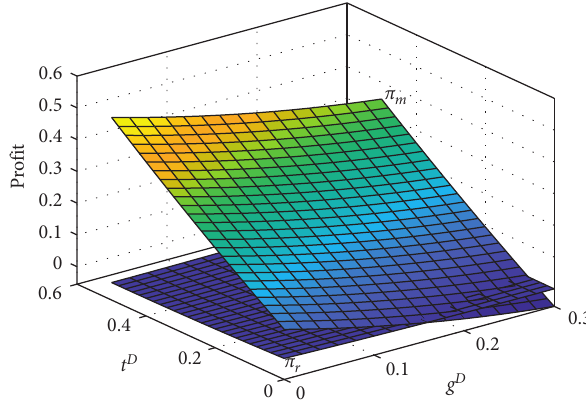
Figure 9: The impact of t D and g D on profit.